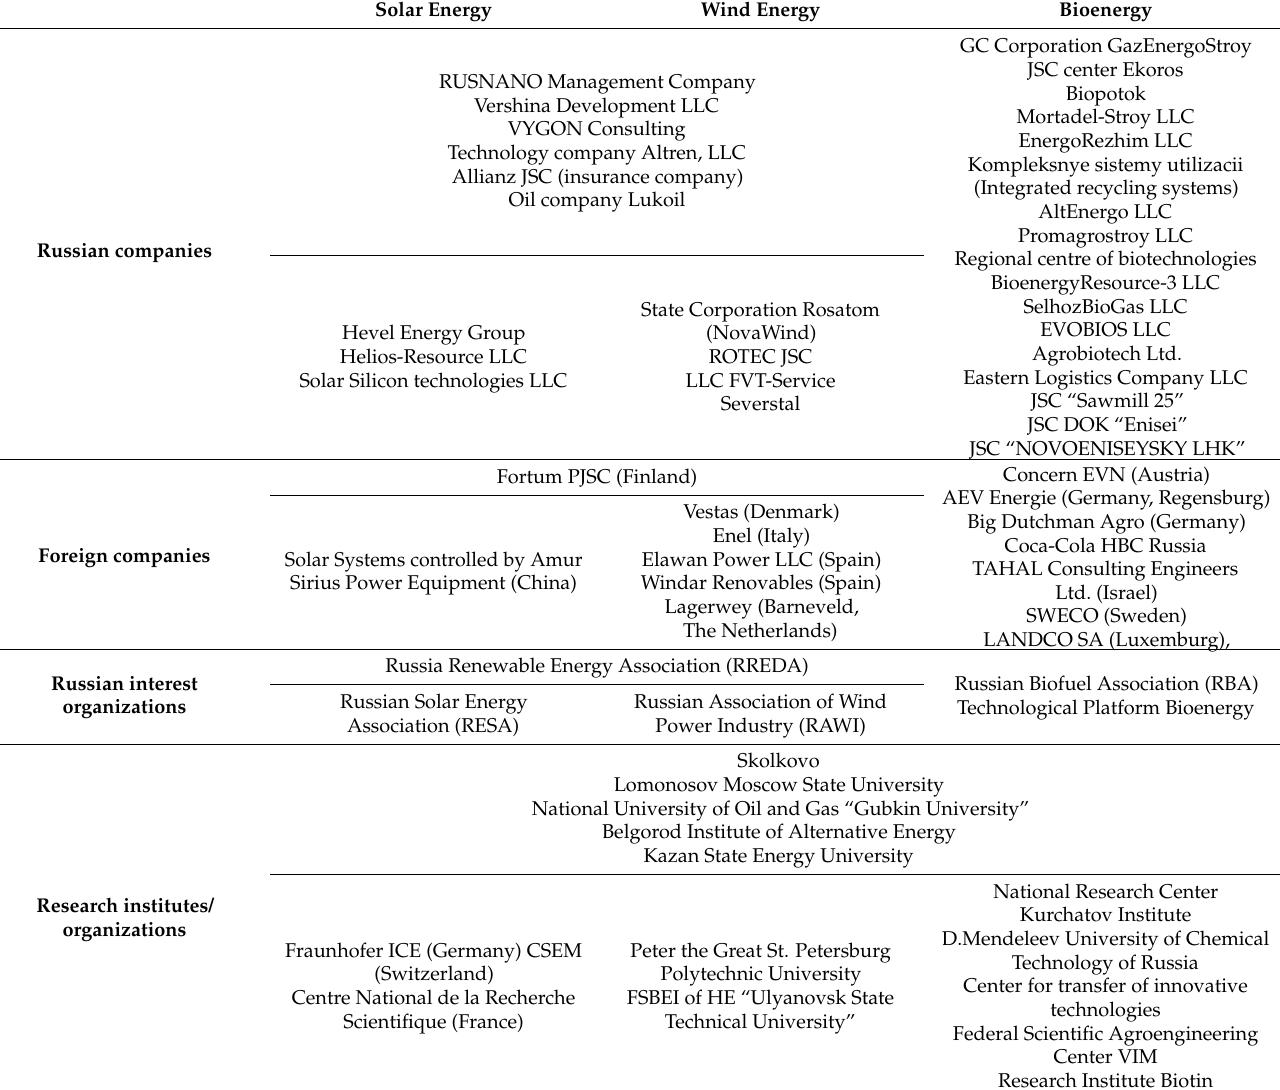
Table 3. Overview of the main stakeholders in the renewable energy